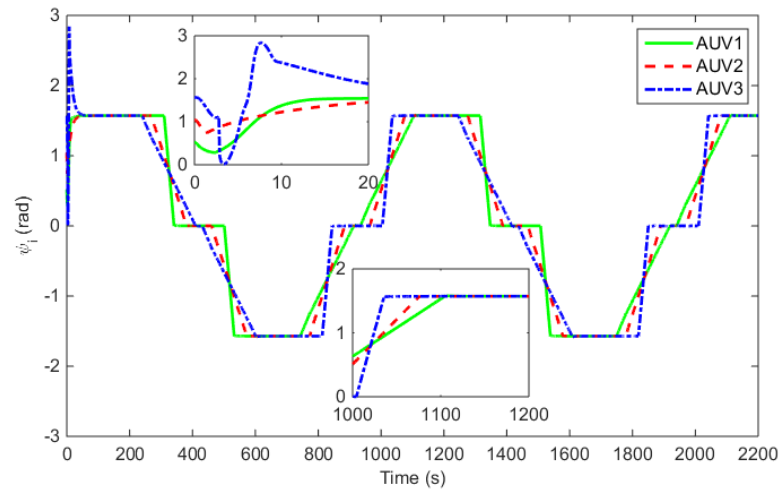
Figure 10. Heading angles of three AUVs.